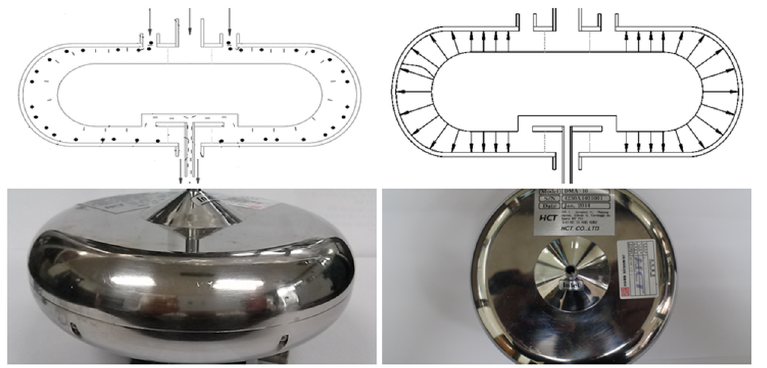
Fig 3. Schematic diagram and photo of an